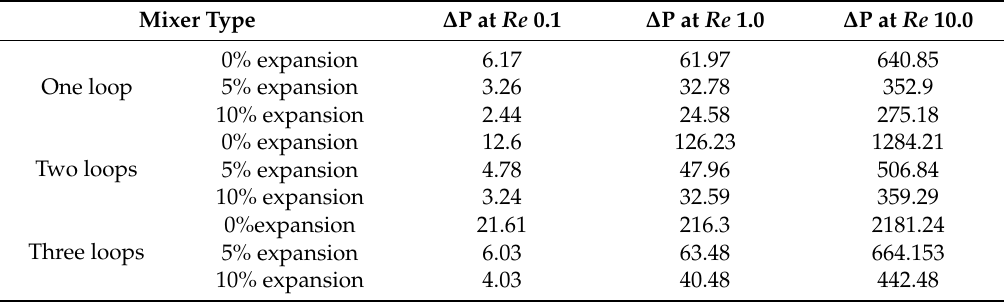
Table 7. Pressure drop amongst various types of mixers. All the values are in Pascal.